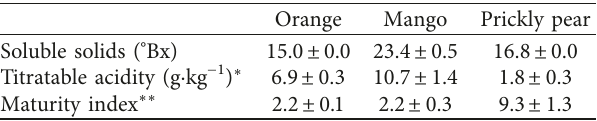
Table 1: Maturity stage parameters of orange, mango, and prickly